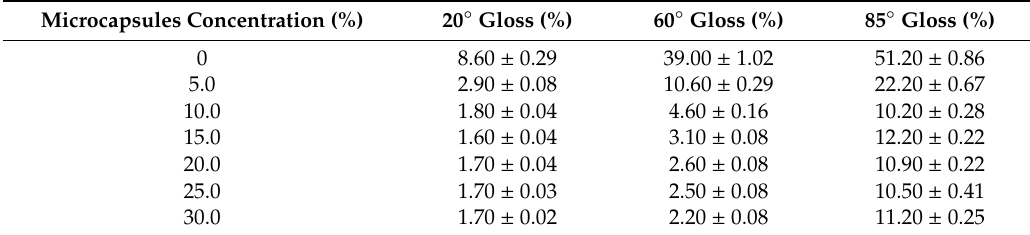
Table 4. E ff ect of microcapsule concentration on gloss.